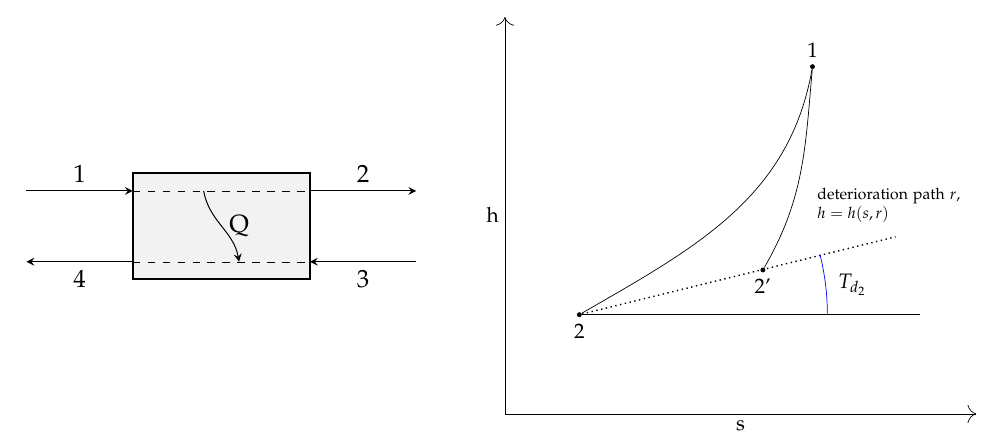
Figure 8. Deterioration path of heat source in a heat